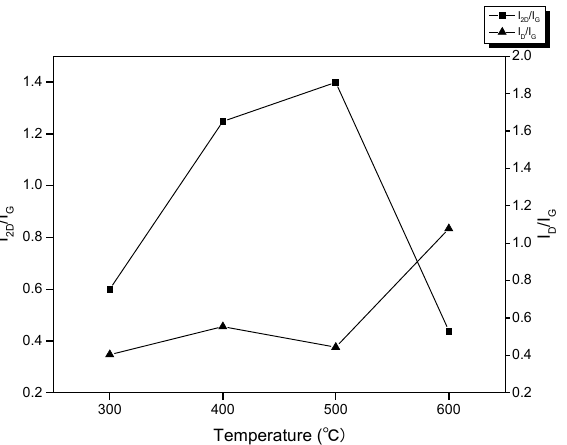
Figure 7. Property index of graphene by benzene grown at each growth temperature.